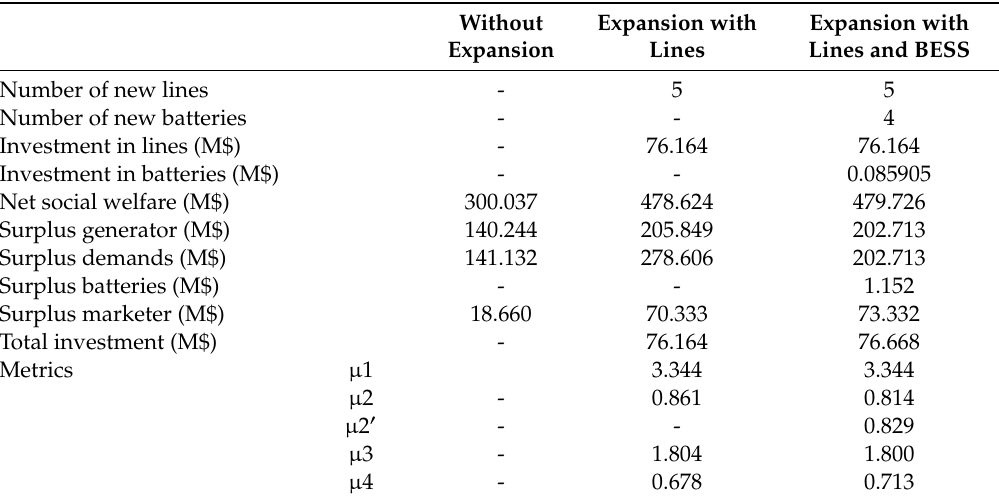
Figure 7. Results of multiple planning periods. Table 12. Results of multiple planning